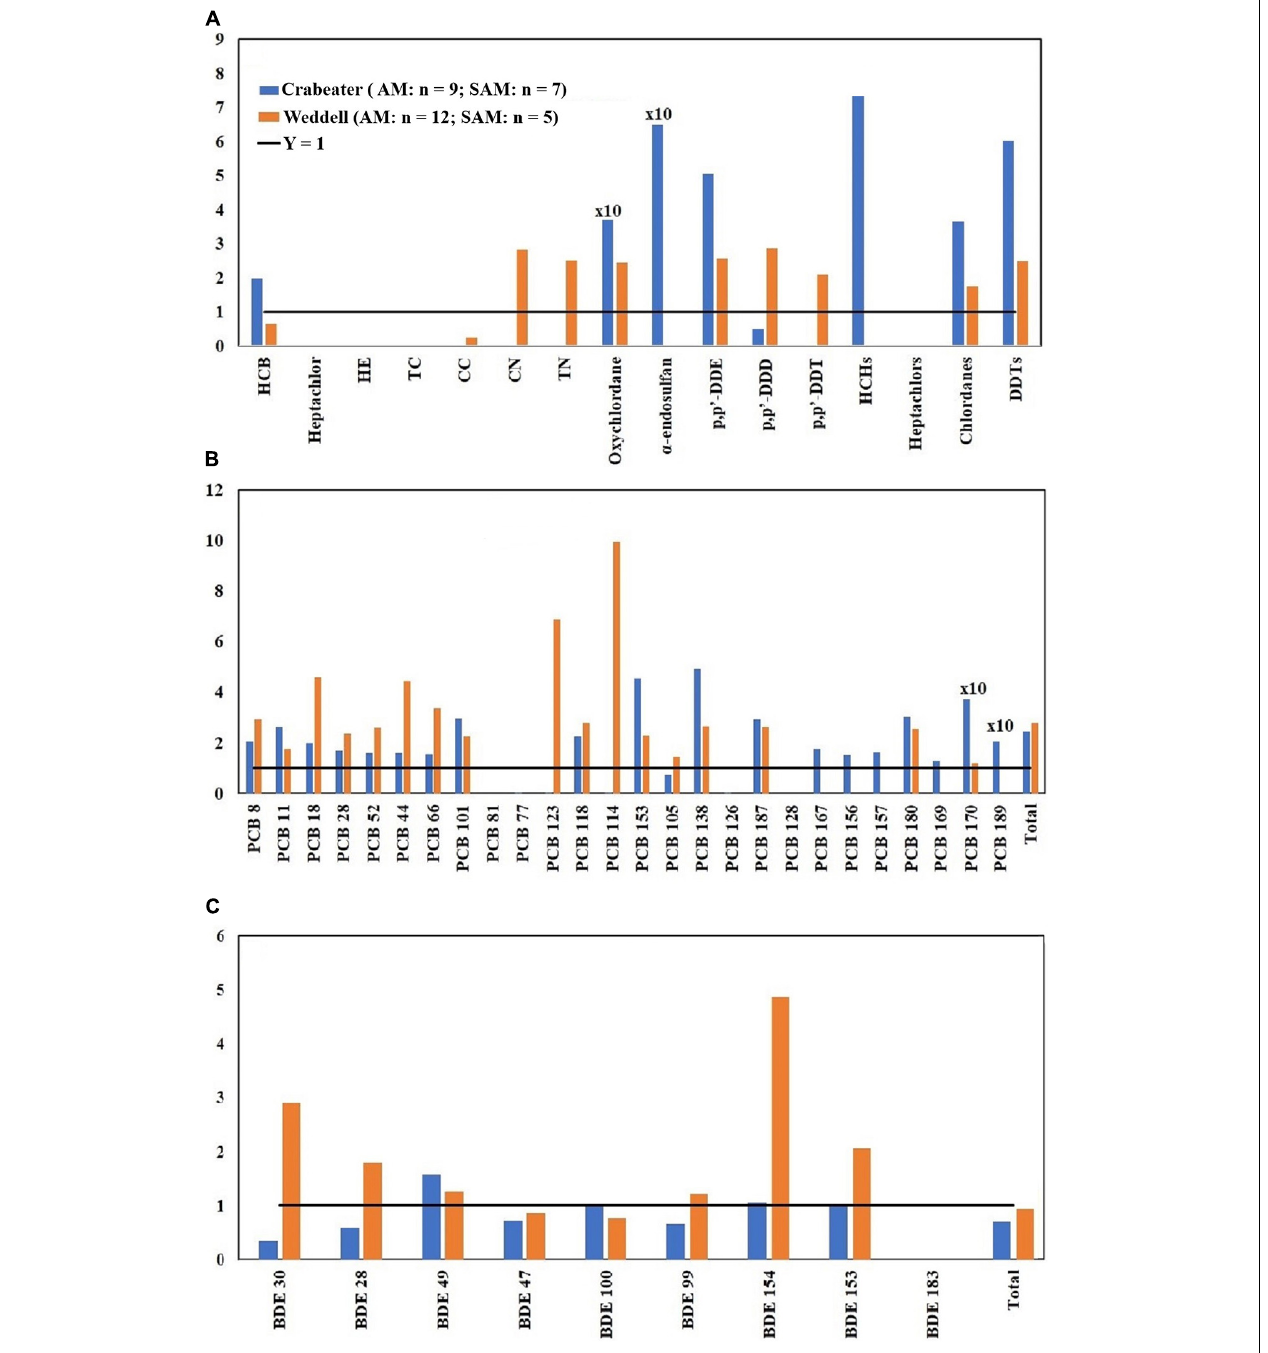
FIGURE 2 | Adult male (AM)/subadult male (SAM) concentration ratios of OCPs (A) , PCBs (B) and PBDEs (C) . HE, heptachlor-epoxide; TC, trans- chlordane; CC, cis- chlordane; CN, cis- nonachlor; TN, trans- nonachlor. See Table 1 for sample size in each group.